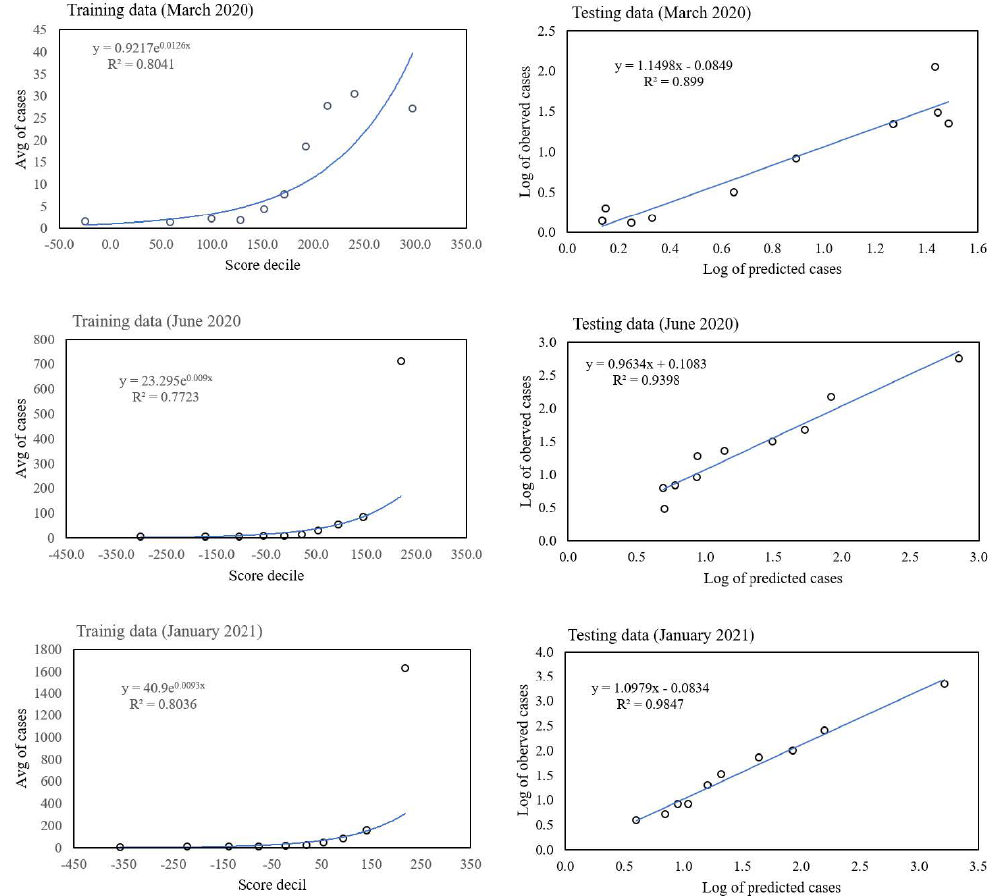
Figure 6. Left—graphs of score from a model for predicting the top 10% of the highest number of cases versus the number of confirmed cases of COVID-19 for the three months March 2020, June 2020, and January 2021 using as training set 70% of spatial cells. An exponential function was used to fit the relation score–number of cases. Right—graphs of number of predicted cases versus the number of actual cases for the 30% hold out set for the same three months.